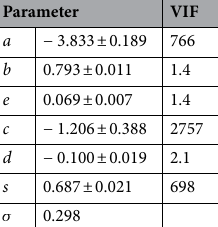
Table 2. Coefficients and related uncertainty, and Variance Inflation Factor (VIF) of the GMPE reported in Eq. (2) for St. Gallen.